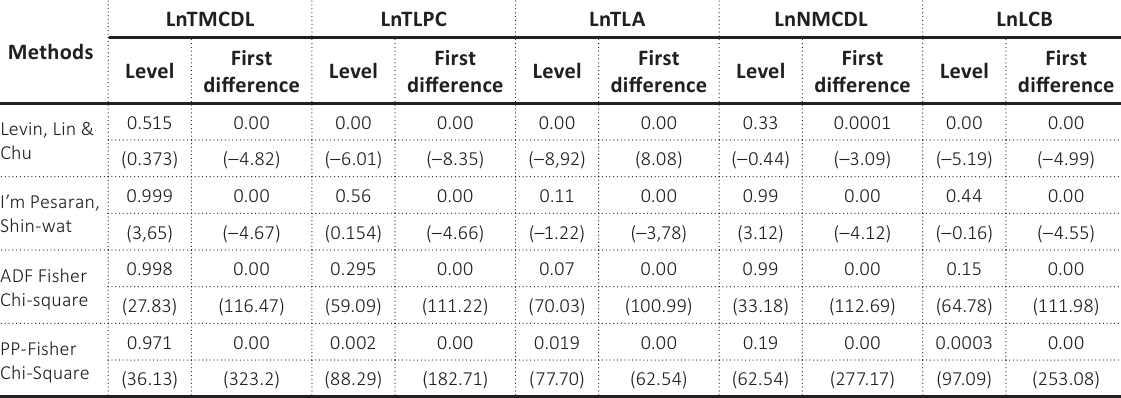
Table 3. Values of stationary or non-stationary tests